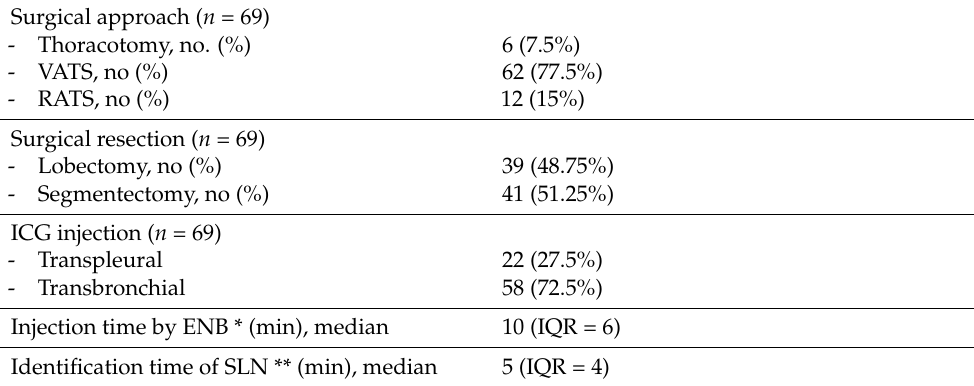
Table 2. Technical